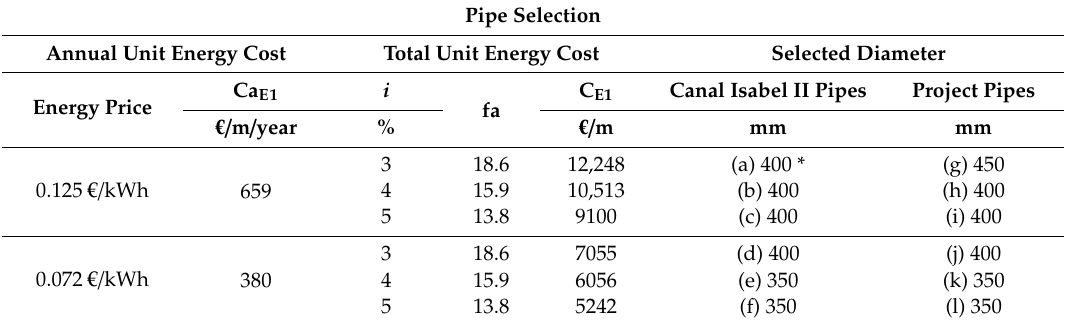
Table 3. Selection of the pipe diameter, depending on the energy prices, diameter series and discount rate considered.